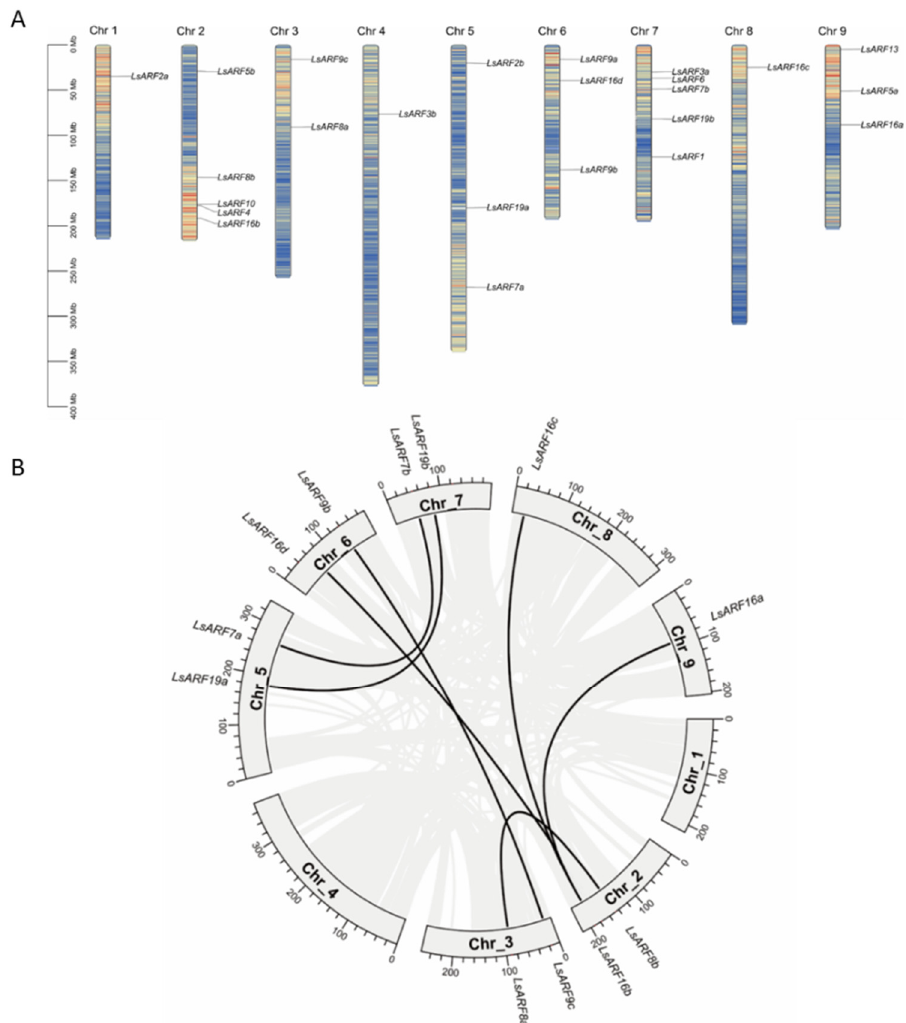
Figure 1. Chromosomal distribution and duplication events of LsARF genes. ( A ) Chromosomal location of members of the LsARF gene family. The chromosome numbers and size are indicated at the top and bottom of each bar, respectively. The number on the right side of the bars designated the approximate physical position of the first exon of corresponding LsARF genes on lettuce chromosomes. ( B ) Mapping of duplicated LsARF genes on the lettuce genome. Grey ribbons indicate a collinear relationship among the blocks in the whole genome, and black ribbons show LsARF